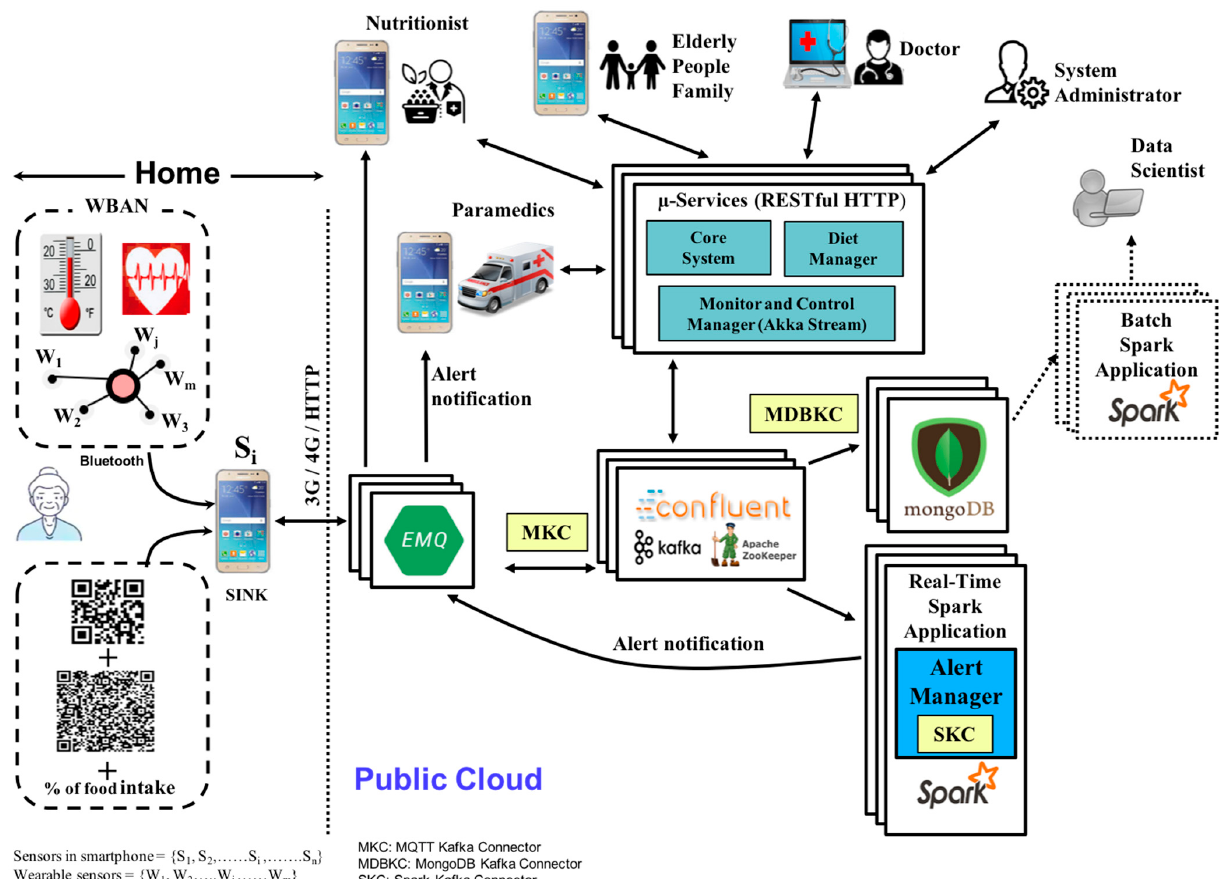
Figure 9. System architecture.